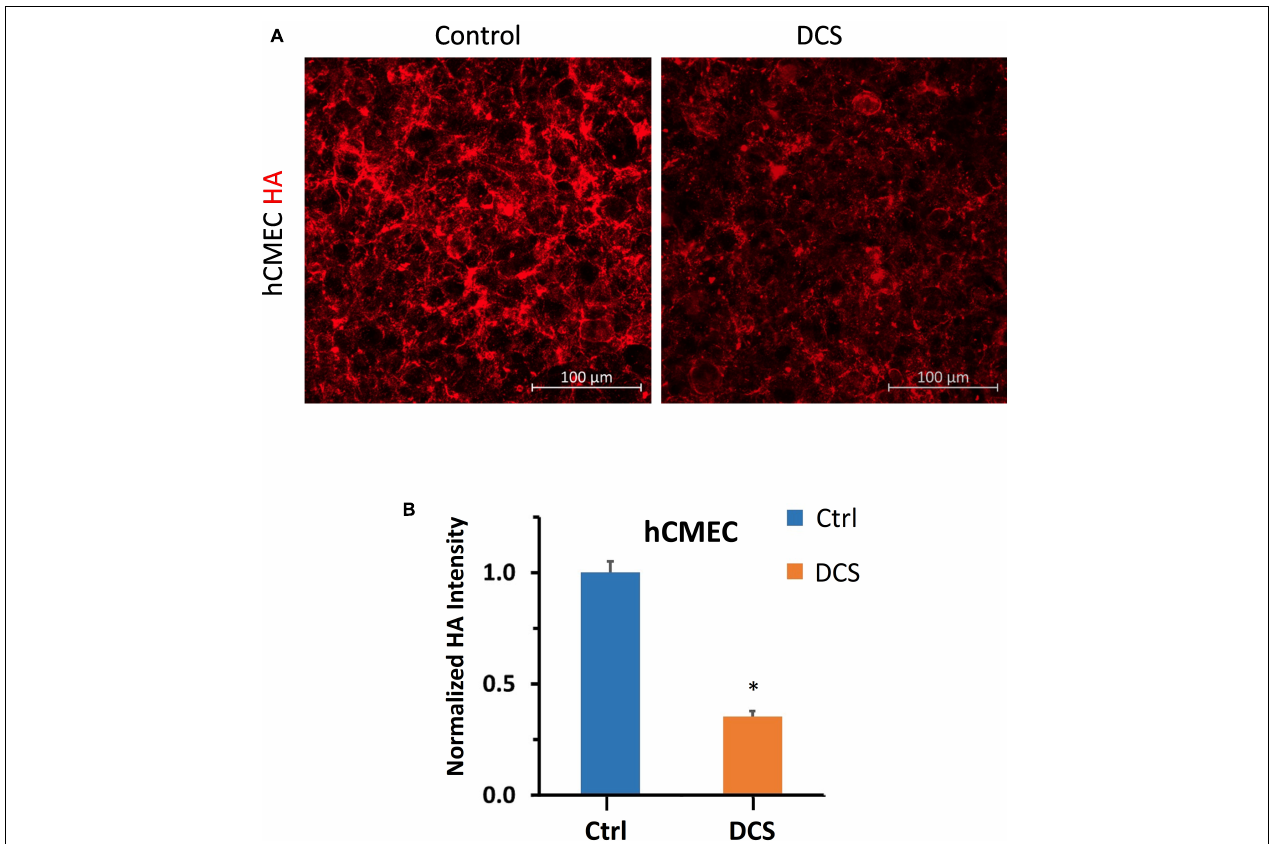
FIGURE 5 | Effects of DCS on HA of endothelial glycocalyx (EG) of in vitro BBB formed by hCMEC monolayer. (A) Confocal images of hyaluronic acid (HA) of EG on in vitro BBB and (B) comparison of HA intensity under control and after 10 min treatment with 1 mA/cm 2 DCS. * p < 0.05.